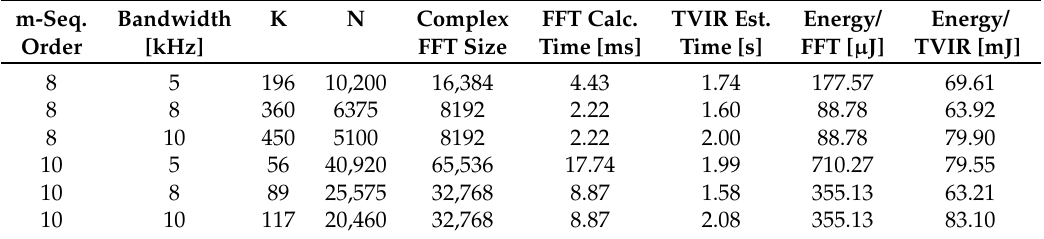
Table 3. TVIR calculation time and energy consumption for TMS320VC5505 digital signal processor.